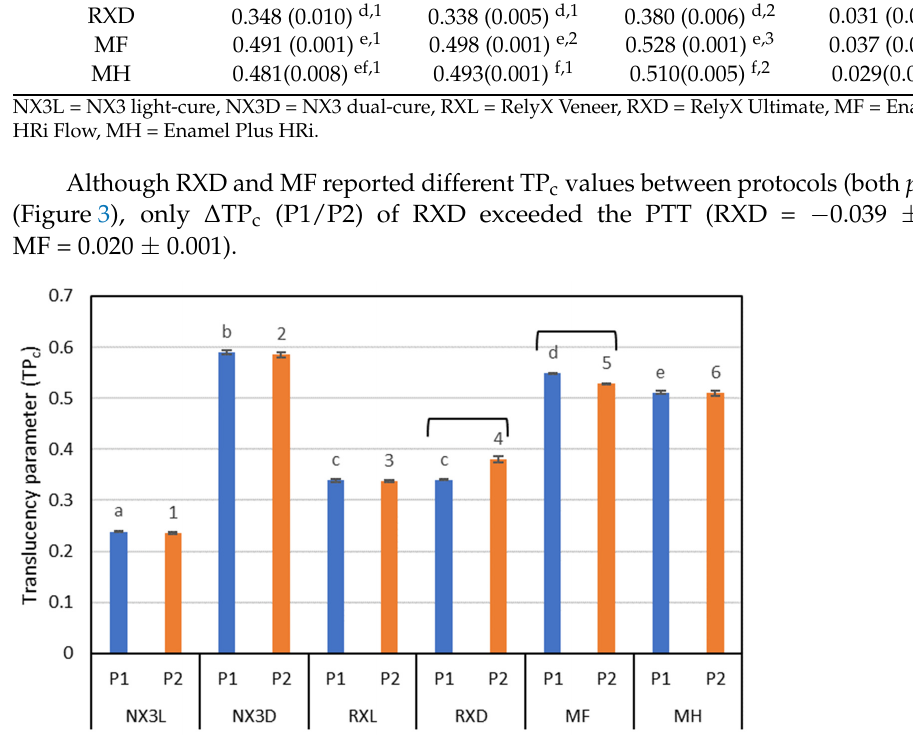
Figure 3. Translucency parameter (TP c ) values after 7 days of storage in water. Different letters identify statistical differences between P1 groups. Different numbers identify statistical differences between P2 groups. Bars identify a statistical difference between P1 and P2 ( p < 0.05). NX3L = NX3 light-cure, NX3D = NX3 dual-cure, RXL = RelyX Veneer, RXD = RelyX Ultimate, MF = Enamel Plus HRi Flow, MH = Enamel Plus HRi.